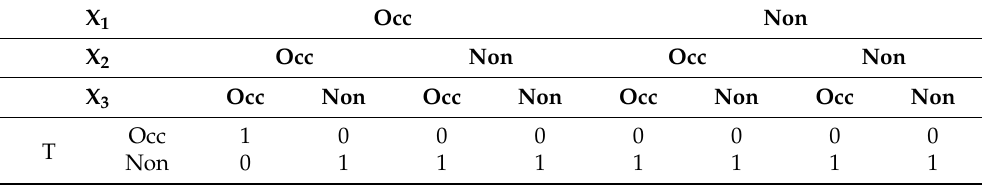
Table 1. CPT corresponding to the AND gate in FT (Occ: occurred; Non: non-occurred). X 1 Occ Non